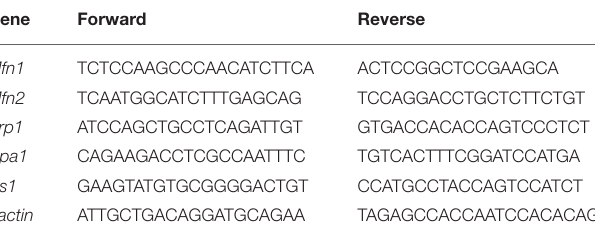
TABLE 2 | The sequences (5 ′ -3 ′ ) of the primers used in Real Time